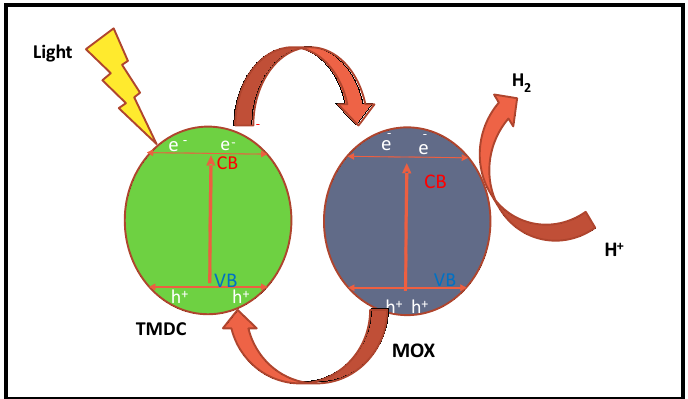
Figure 3. Schematic illustration showing electron transfer from 2D TMDC nanosheet to metal oxide such as TiO 2 for hydrogen evolution reaction.